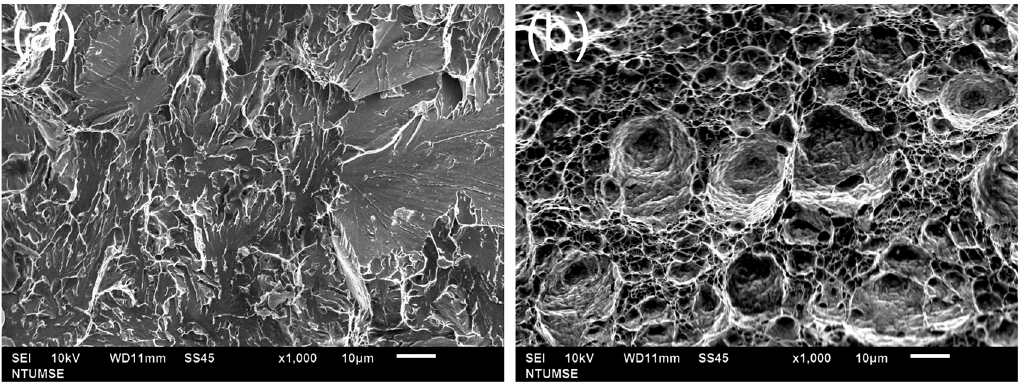
Figure 5. SEM-secondary electron images showing the fracture surfaces in the propagation regions after Charpy tests in 720 °C-tempered ( a ) S690Q steel and ( b ) NiCu